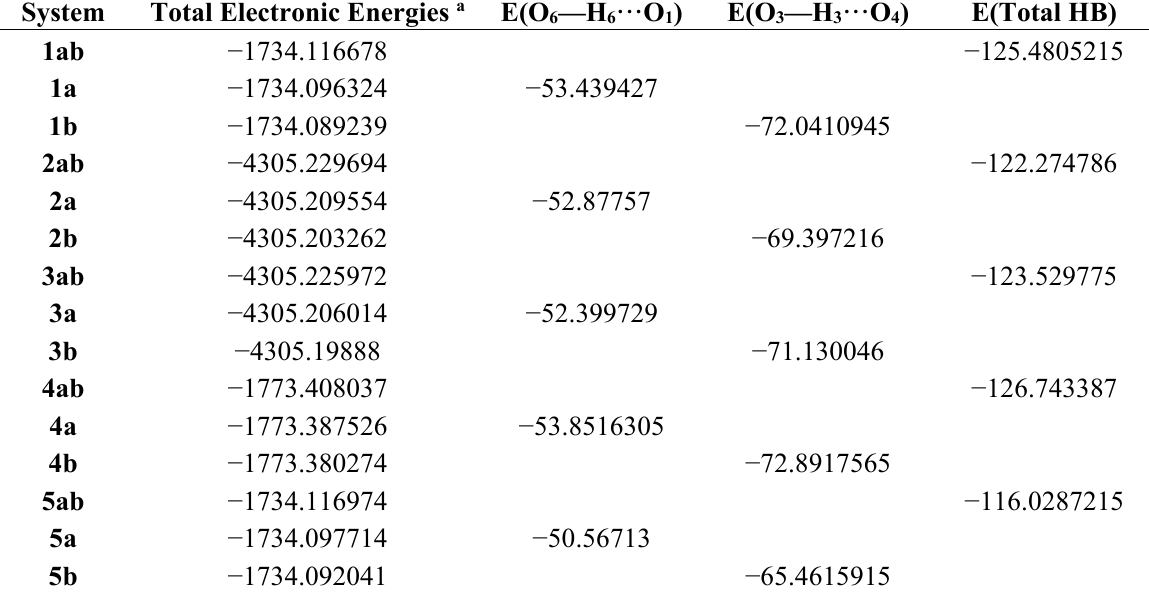
Table 2. Total electronic energies (in Hartree) and HB energies (in kJ/mol) of hydrogen bonded conformers of compounds 1 – 5 calculated at B3LYP/6-31G* level of theory.